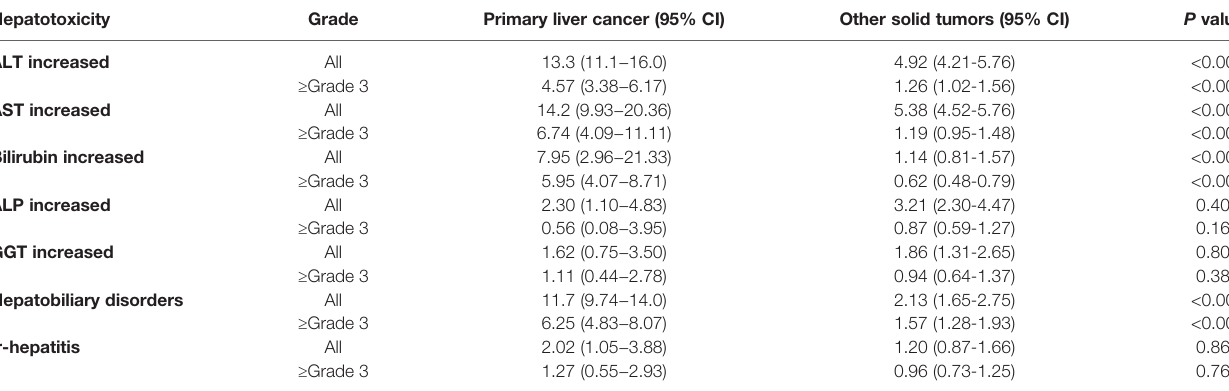
TABLE 3 | Incidence of hepatotoxicity in primary liver cancers and other solid tumors treated with anti-PD-1/PD-L1. Hepatotoxicity